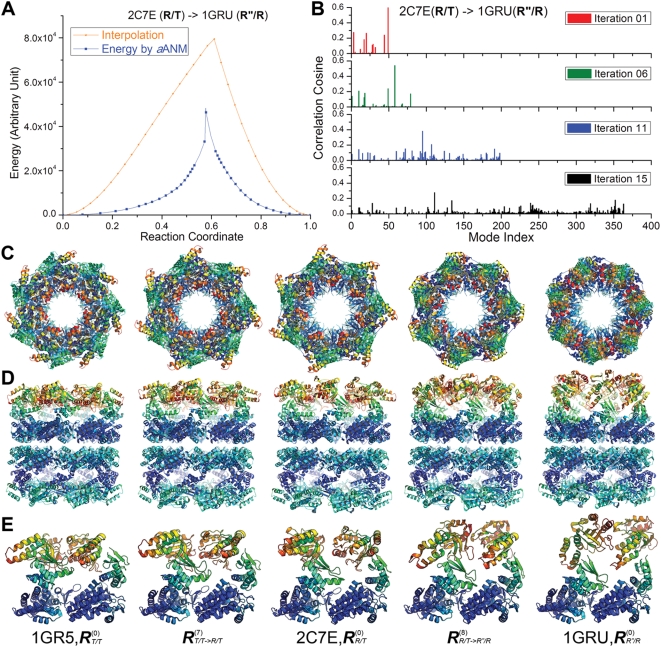
Transition among T/T→R/T→R″/R forms
of the intact GroEL complex.(A) Energy profiles of the intact GroEL complex
(R/T→R″/R) along the reaction coordinate computed
by aANM (blue) and Cartesian interpolation (orange)
using the double-well potential given by Eq. (7). (B) Contribution
of different modes at various steps (1, 6, 11 and 15) along the
transition R/T→R″/R. Broader numbers of higher
frequency modes are recruited as the structure approaches the energy
barrier (see Table
5). (C) Top view of structures sampled along the transition.
Snapshots corresponding to conformations , , ,  and  are shown. (D) Side view of the same structures.
(E) Close-up views of pairs of adjacent subunits. The diagrams in
panels C–E are color-coded according to the mobilities of
residues (red: most mobile; blue: almost fixed). Note that the
equatorial domains of cis ring subunits are almost
fixed, while the largest motions occur at the apical domains of the
same subunits.